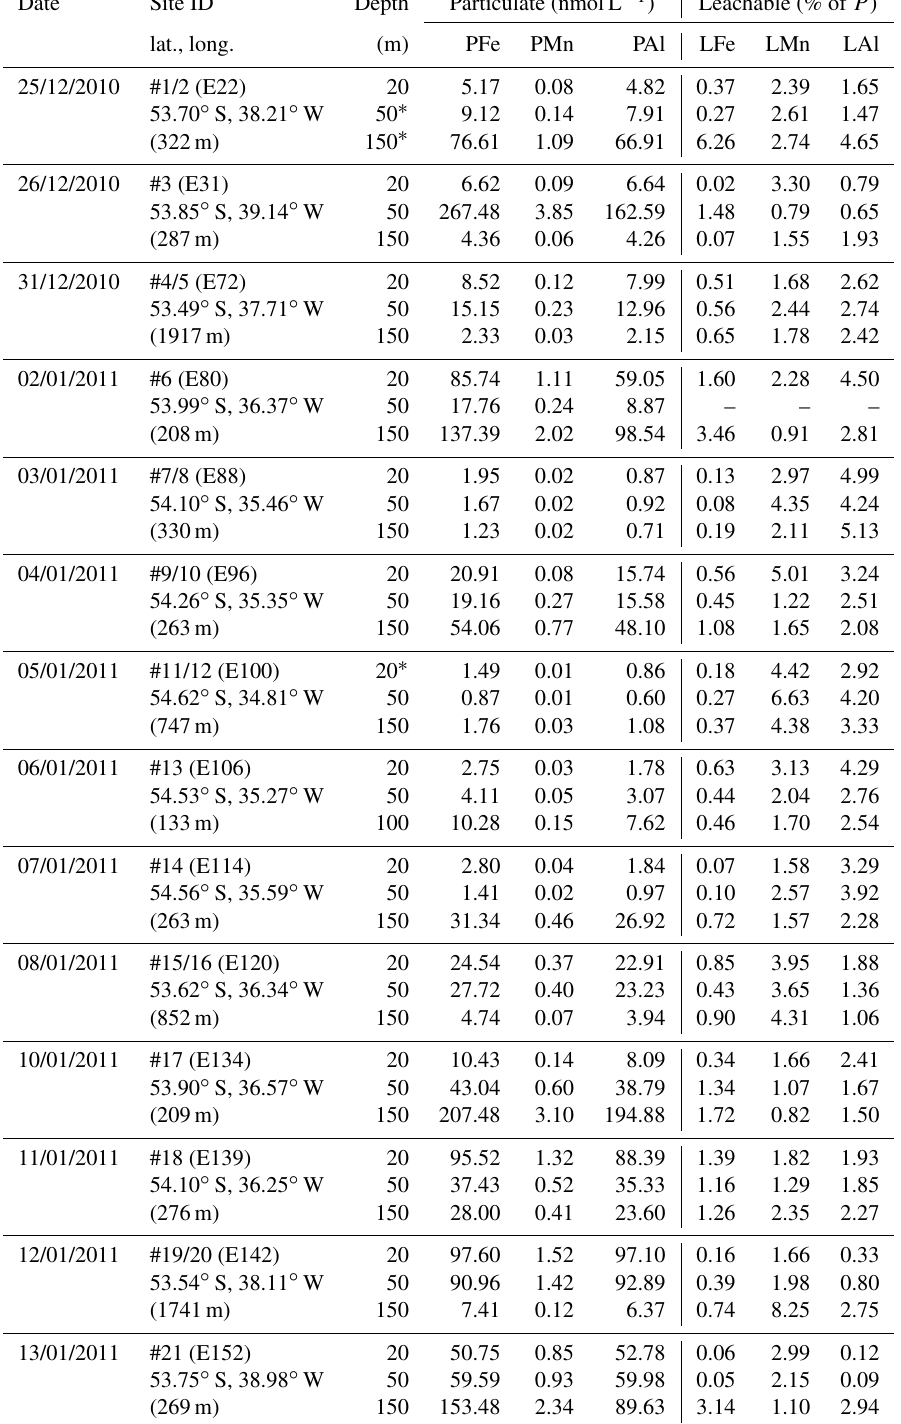
Table 2. SAPS samples: the particulate Fe (PFe), Mn (PMn), and Al (PAl) concentrations in the top 150m of the water column at the 14 sites visited during JR247. The particulate fraction, P , is the sum of leachable ( L ) and refractory ( R ) fractions. Because of low concentrations, the leachable fraction is indicated in percent of the P fraction. Additional information covers sampling date, site (station) ID, event number, latitude and longitude, and water column depth. (Depths marked by ∗ indicate that the polycarbonate filter was corrupted after retrieving the